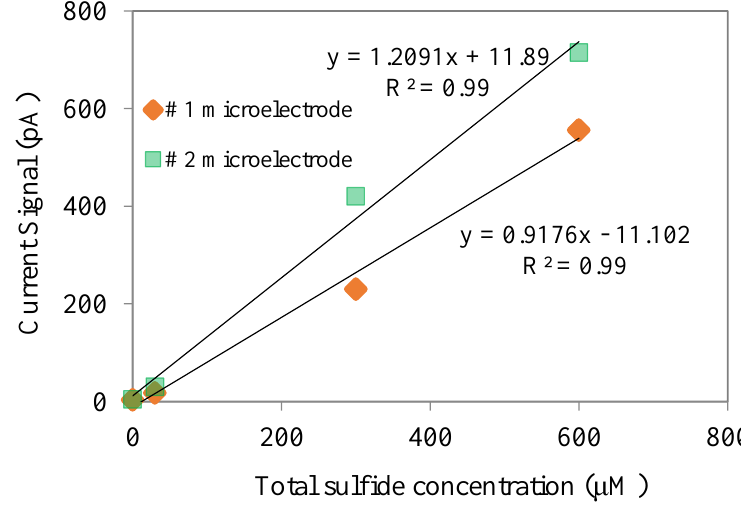
Figure 2. Calibration curve of H 2 S microelectrodes.